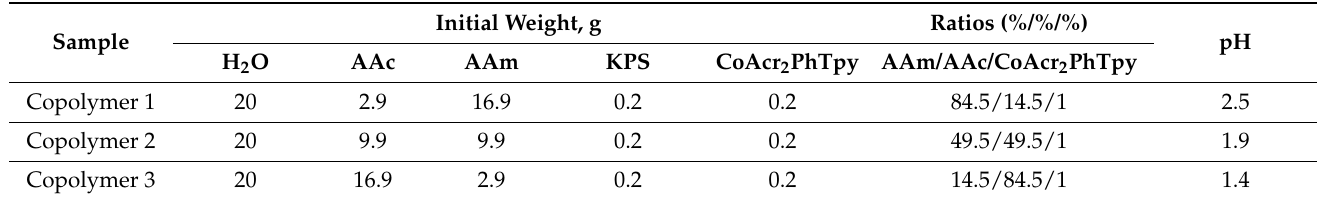
Table 1. Composition of precursor solutions.